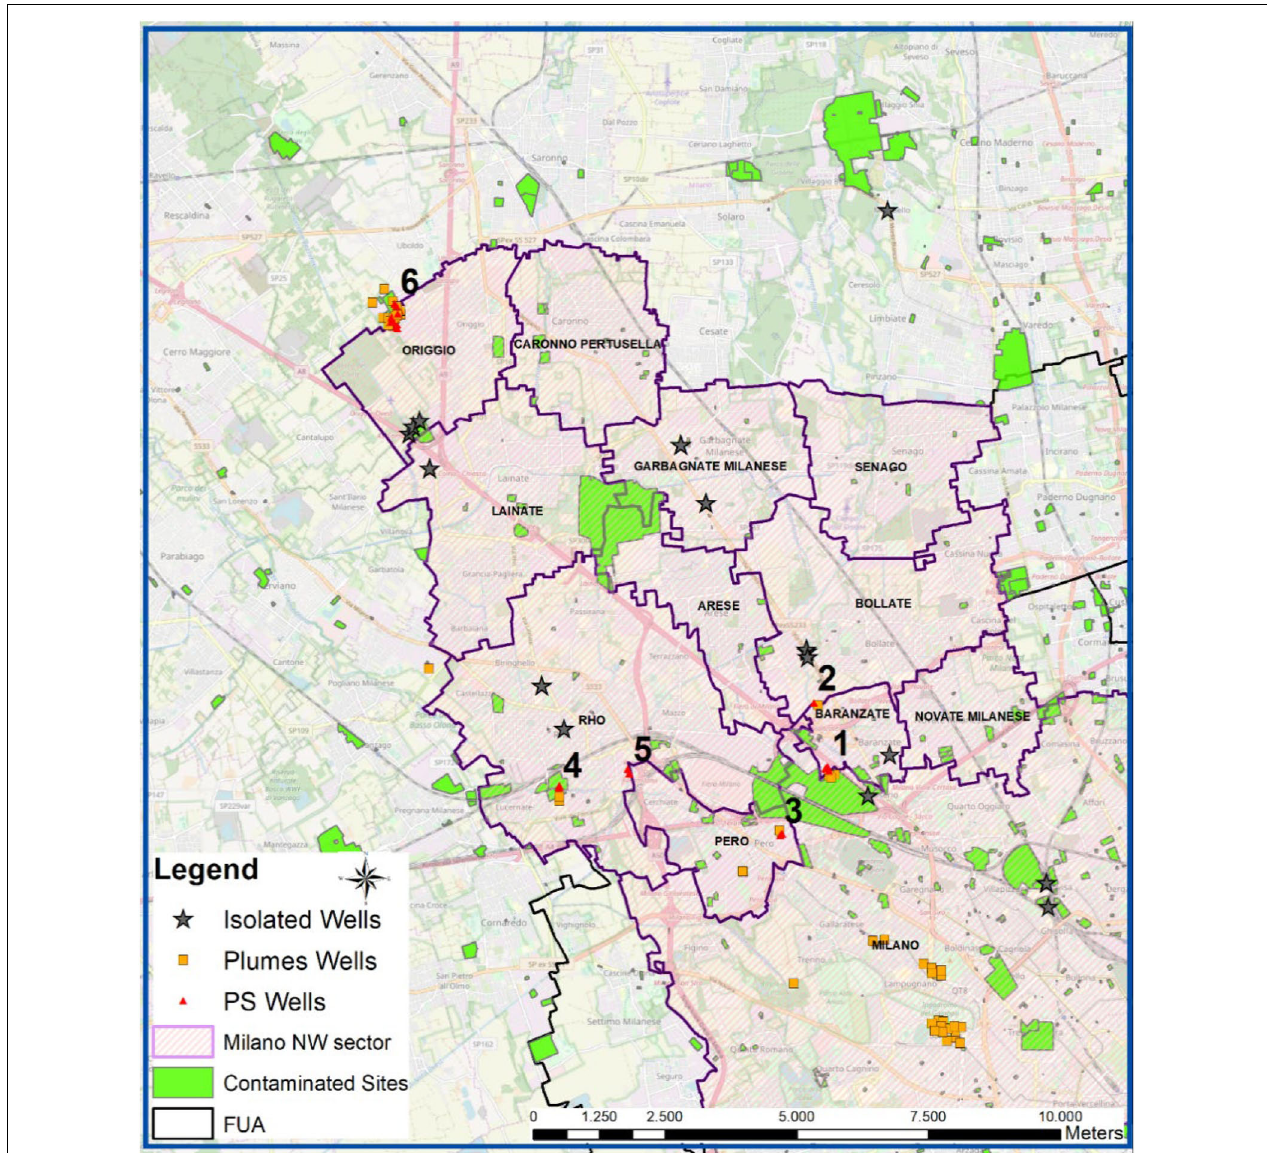
FIGURE 7 | Monitoring wells belonging to clusters 2 to 15 overlapped with contaminated/potentially contaminated sites; numbered triangles correspond to PSs simulated in the transport